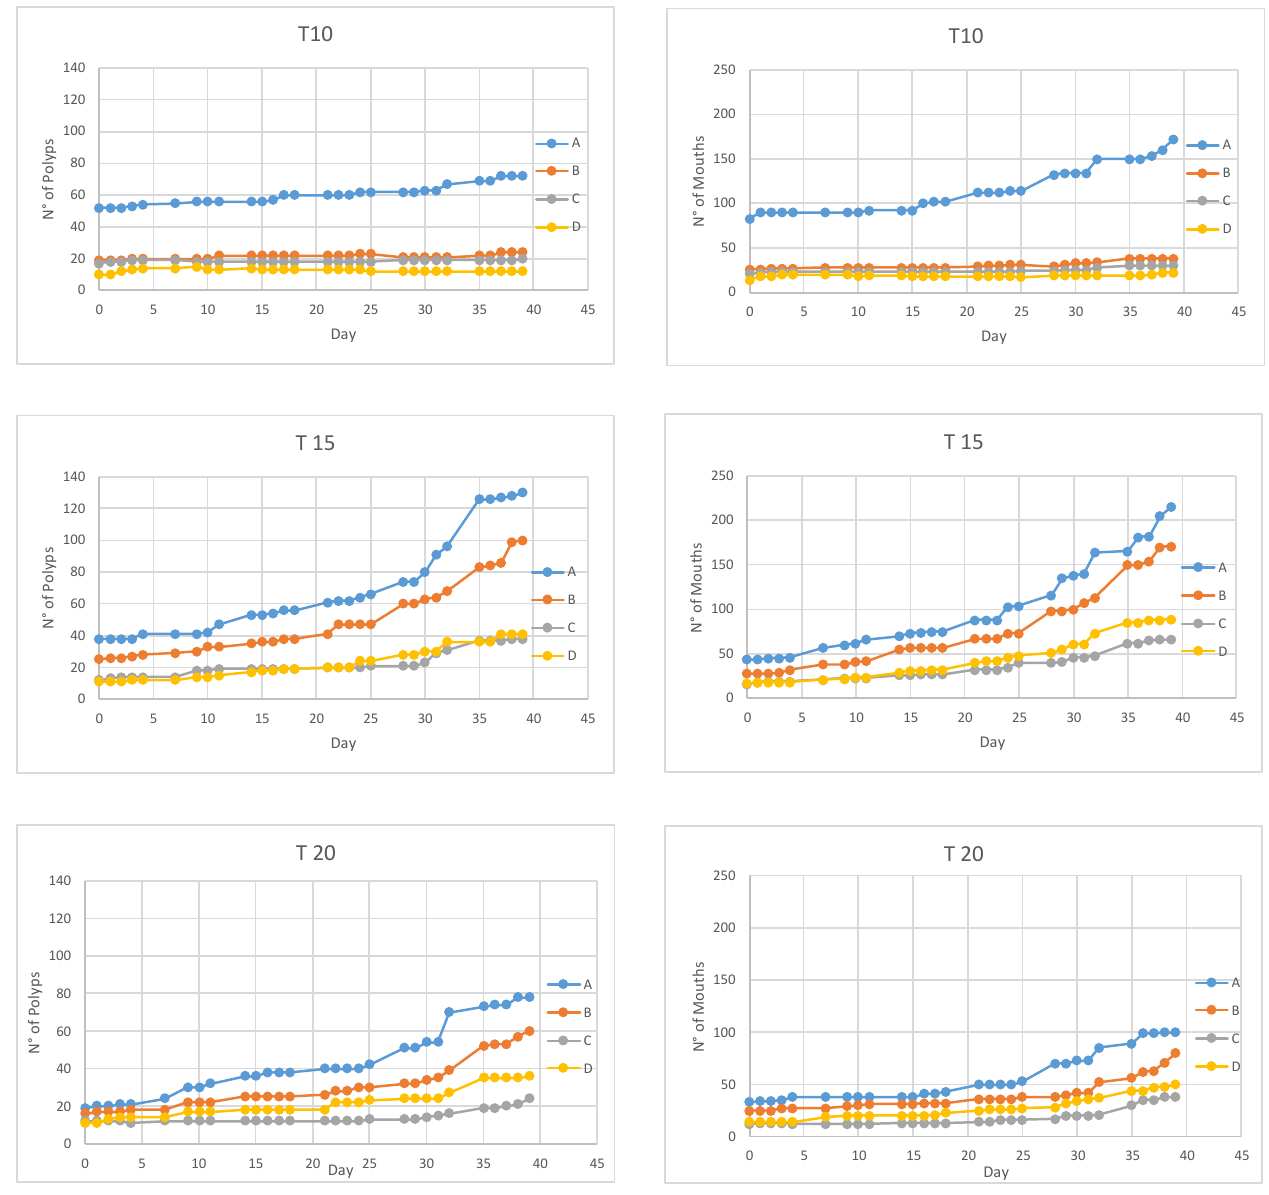
Figure 3. Total number of polyps ( left ) and mouths ( right ) observed during the 39 days of incubations at 10 ◦ C (top), 15 ◦ C (middle) and 20 ◦ C (bottom). ( A – D ) The four replicates for each temperature. Results of the GLMM provided positive and significant relationships for the three levels of the treatment and the number of polyps as a function of the observational time, with significantly different slopes of the regression lines in the three levels of the treatment factor (Table 2, Figure 4a, Supplementary S1). The estimated regression slope for T15 (be- ta T15xDay = 0.044) resulted higher than for T20 (beta T20xDay = 0.036). The estimated model goodness of fit is higher than 90% (R 2 = 0.91). Similar results were observed for the GLMM considering the number of mouths as the response variable (Table 2, Figure 4b, Supple- mentary S1): the estimated regression slope for T15 (beta T15xDay = 0.047) resulted higher than for T20 (beta T20xDay = 0.030) and the R 2 resulted equal to 0.94.